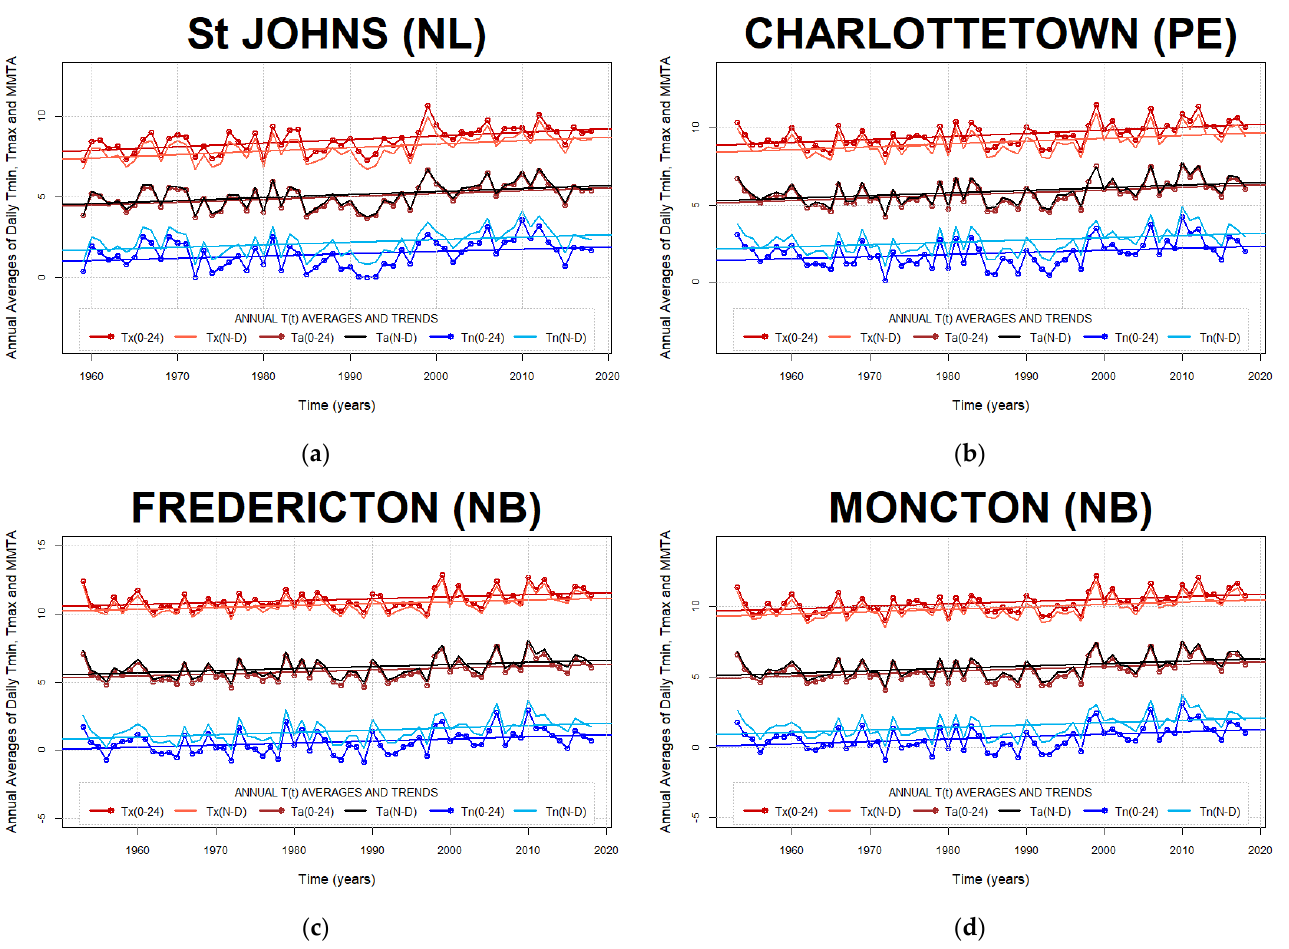
Figure A11. Cont